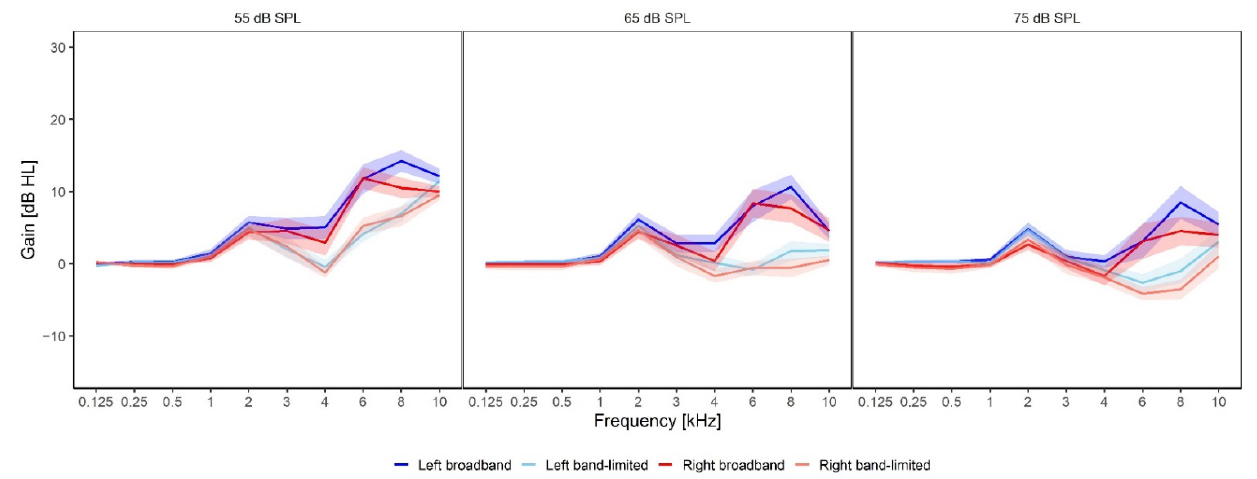
Figure 3. Gain provided by the hearing aids in the two different treatment conditions. The dark blue curve is the gain provided in the left ear in the broadband condition, while the dark red curve is the gain provided in the right ear in the broadband condition. The light blue and red curves are the gain provided in the band-limited condition in the left and right ear, respectively. The gain was measured at 55, 65 and 75 dB SPL with the ISTS.